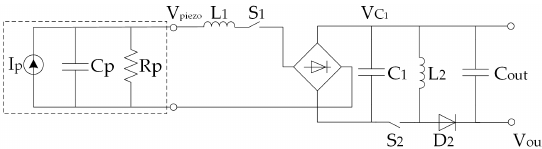
Figure 51. The circuit of the DSSH, ESSH and ASSH rectifiers.